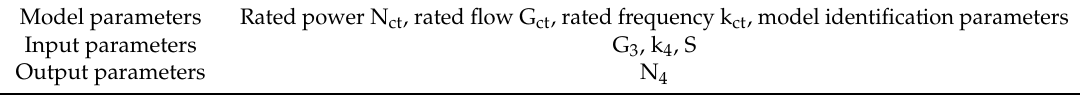
Table 14. Parameters of custom cooling tower